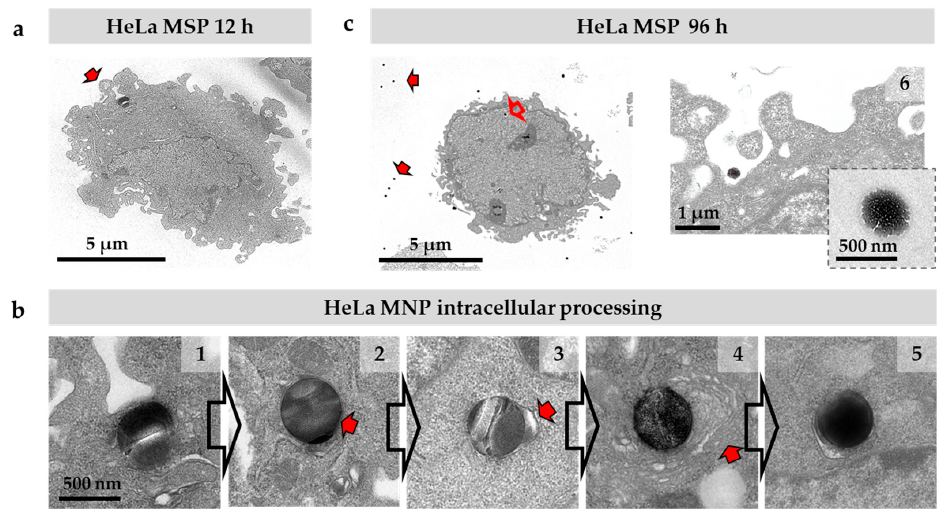
Figure 2. Intracellular route of MSP in HeLa cells by transmission electron microscopy images. ( a ) MSP are engulfed via endocytosis by filopodia (arrow). ( b ) Particles are immediately incorporated inside the endocytic membranes (#1 corresponds to 6 h of incubation). A thin membrane surrounding the MSP is visible in some sections (#2, arrow, corresponds to 12 h of incubation). Encapsulated particles fuse to lysosomes (#3, arrow, corresponds to 24 h of incubation). Some particles are coated with membranes (#4, arrow, corresponds to 48 h of incubation) apparently undergoing an autophagia-like process (#4, #5). After 96 h, many intracellular particles show a dense core and a compacted appearance suggesting biomolecular/biofluid infiltration (#5, corresponds to 72 h of incubation). ( c ) Many extracellular MSP are observed in cultures 96 h after the exposition (#6, inset). Extracellular particles display an eroded surface and a dense core. Cracks in the particles (#1, #2, #3) are due to artefacts resulting from ultrathin sectioning.